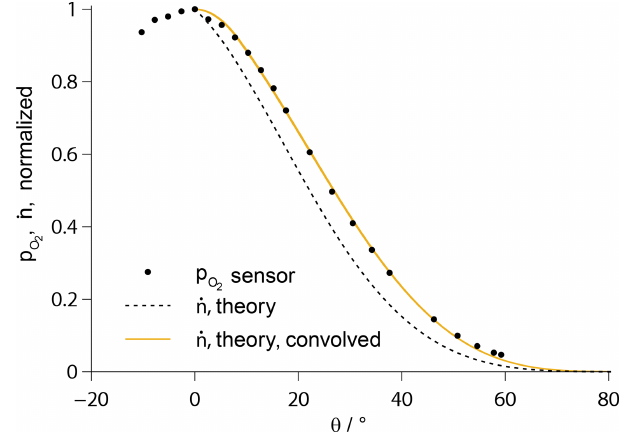
Figure 4. Theoretical profile of the number flux density accord- ing to Giordmaine and Wang (1960), convolved with the electrode length and fitted to the measurement data of a platinum sensor (solid line). The profile prior to convolution is additionally given (broken line).